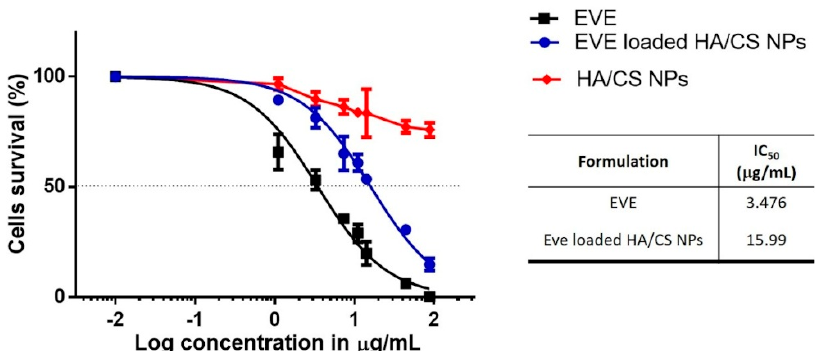
Figure 5. Cytotoxicity results obtained by incubating hMSCs with EVE loaded HA/CS NPs, HA/CS NPs and free EVE. The graph shows the cell viability curves for the experimental conditions fitted with a sigmoidal dose-response curve. The resulting IC50 values are shown in the table. Results were expressed as mean ± SD.